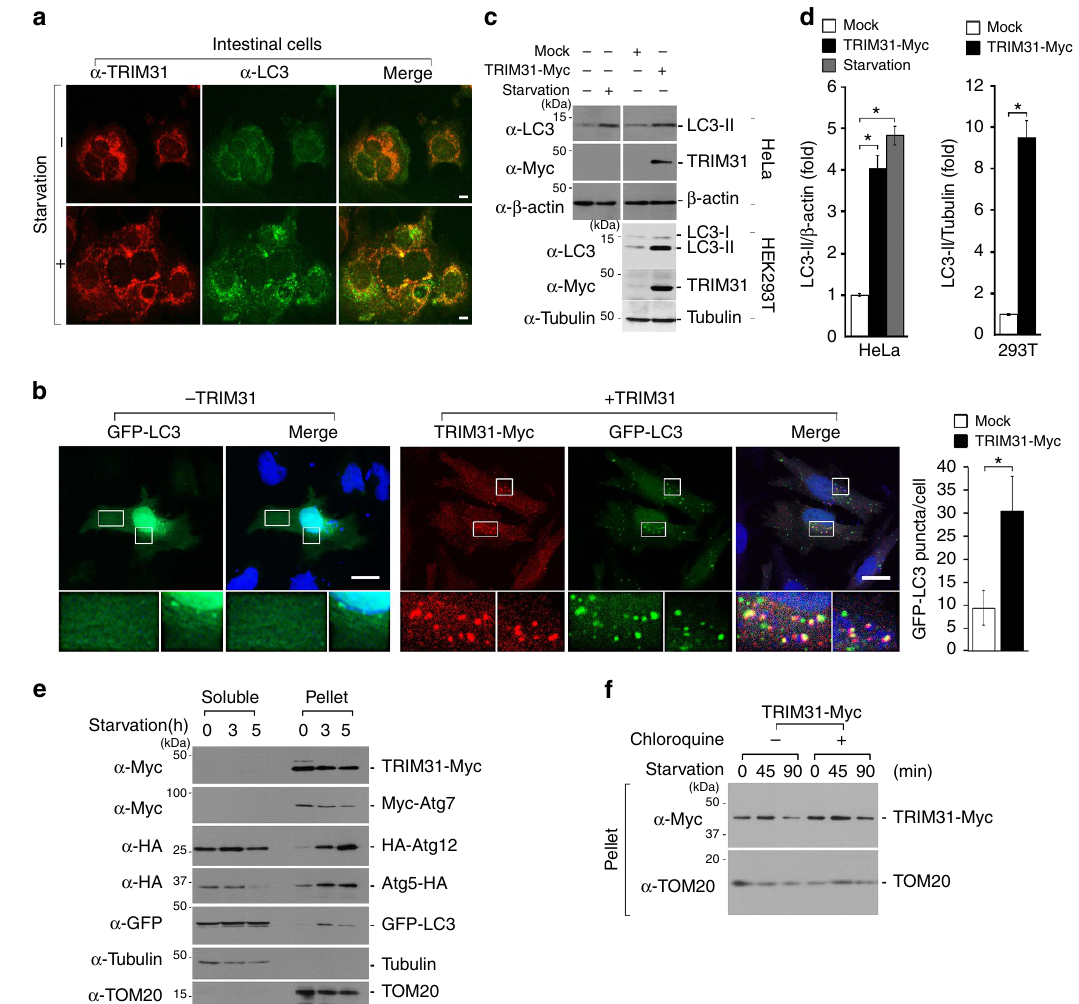
Figure 2 | Human TRIM31 induces autophagy. ( a ) Starvation enhances colocalization of endogenous TRIM31 and LC3 in the intestinal epithelial cell line, Caco-2. Cells were incubated with complete media (-starvation) or serum-free DMEM for 6h, immunostained with anti-TRIM31 and anti-LC3 antibodies, and then analysed by confocal microscopy. Scale bars, 5 m m. ( b ) TRIM31-Myc (red) colocalizes with GFP-LC3 (green) and accumulates LC3-positive puncta in HeLa cells. TRIM31-Myc was stained using anti-Myc antibody and analysed by IFA. Blue, DAPI. Scale bars, 5 m m. Right graph, quantification of LC3 puncta in HeLa cells expressing either Mock or TRIM31-Myc. * P o 0.01 (Student’s t -test). ( c ) Overexpressed TRIM31-Myc upregulates LC3-II in HeLa (upper panels) and HEK293T (bottom panels) cells. HeLa cells were starved in serum-free DMEM for 8h and then subjected to immunoblot analysis with the indicated antibodies. ( d ) The LC3-II band intensities in c were quantified by scanning densitometry and normalized to the b -actin or tubulin band intensity. * P o 0.01 (Student’s t - test). ( e ) Starvation leads to the enrichment of autophagosomal components in the pellet fraction of HeLa cells. HeLa cells were transfected with plasmids expressing TRIM31-Myc, Myc-Atg7, HA-Atg12, Atg5-HA or EGFP-LC3 and then starved in serum-free DMEM for the indicated times. Cells were separated into soluble and pellet fractions by centrifugation, and then subjected to immunoblot analysis with the indicated antibodies. TOM20 and Tubulin were used to indicate the mitochondrial and cytoplasmic compartments, respectively. ( f ) TRIM31-Myc-expressing HeLa cells were starved in serum-free DMEM and then incubated with chloroquine. Cells were lysed with 1% NP-40 and separated into soluble and pellet fractions by centrifugation. Samples were subjected to SDS–PAGE and detected with primary antibodies as indicated. All data are representative of at least two independent experiments (mean ± s.d. in b , d